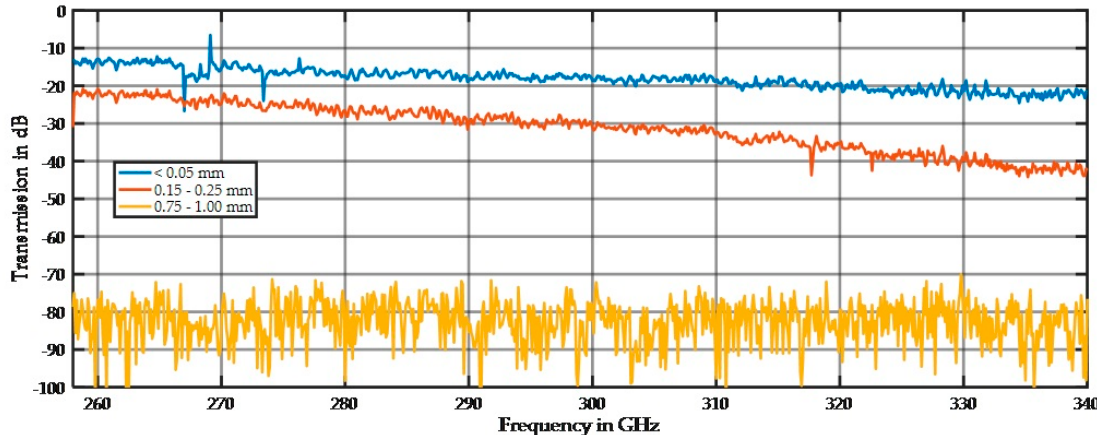
Figure 10. Spectral distribution of three glass particle size fractions at 11 mm sample thickness.